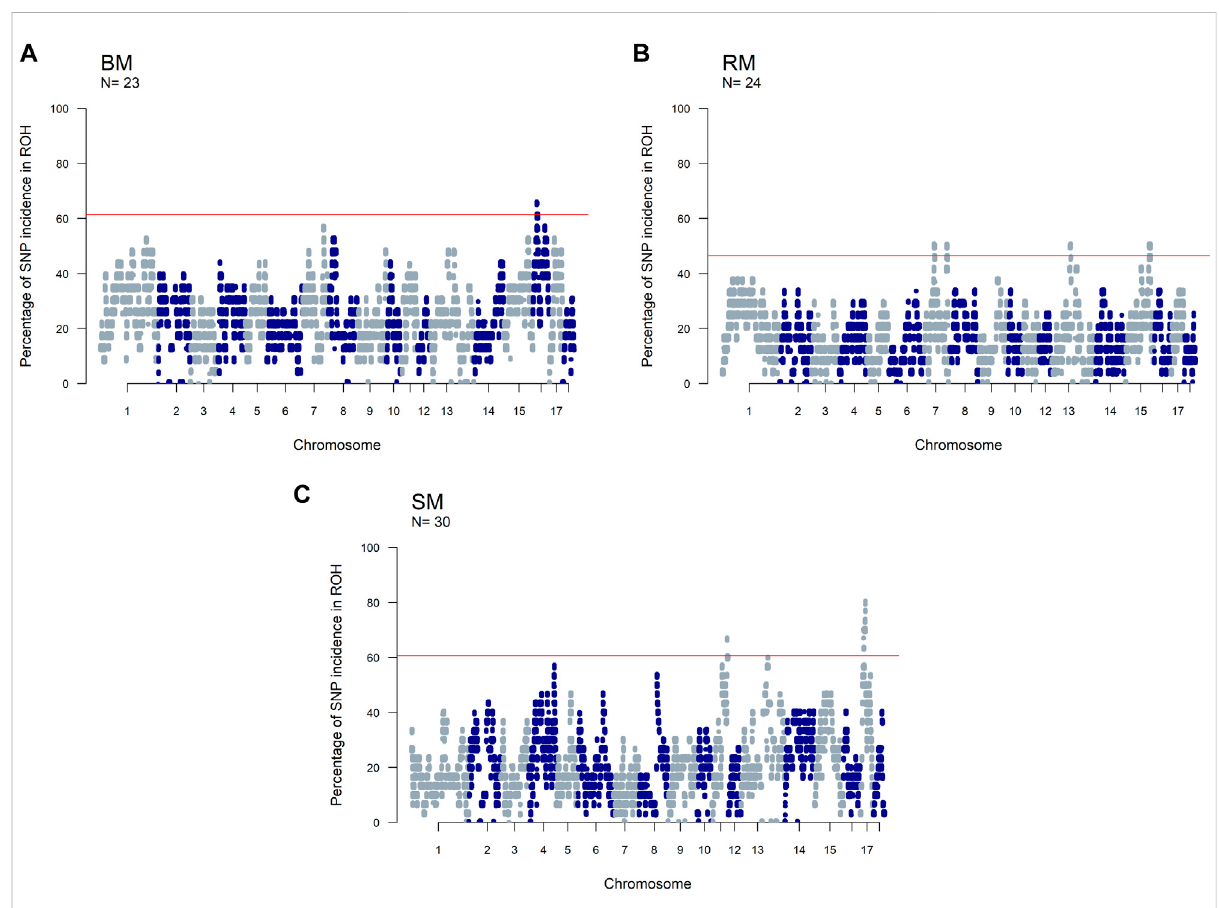
FIGURE 7 Manhattan plots of the incidence of SNPs in ROH for three Mangalitsa pig breeds: Blond (A) , Red (B) and Swallow-bellied (C) . The red line corresponds to a population speci fi c p-value above which SNPs are considered to be in ROH